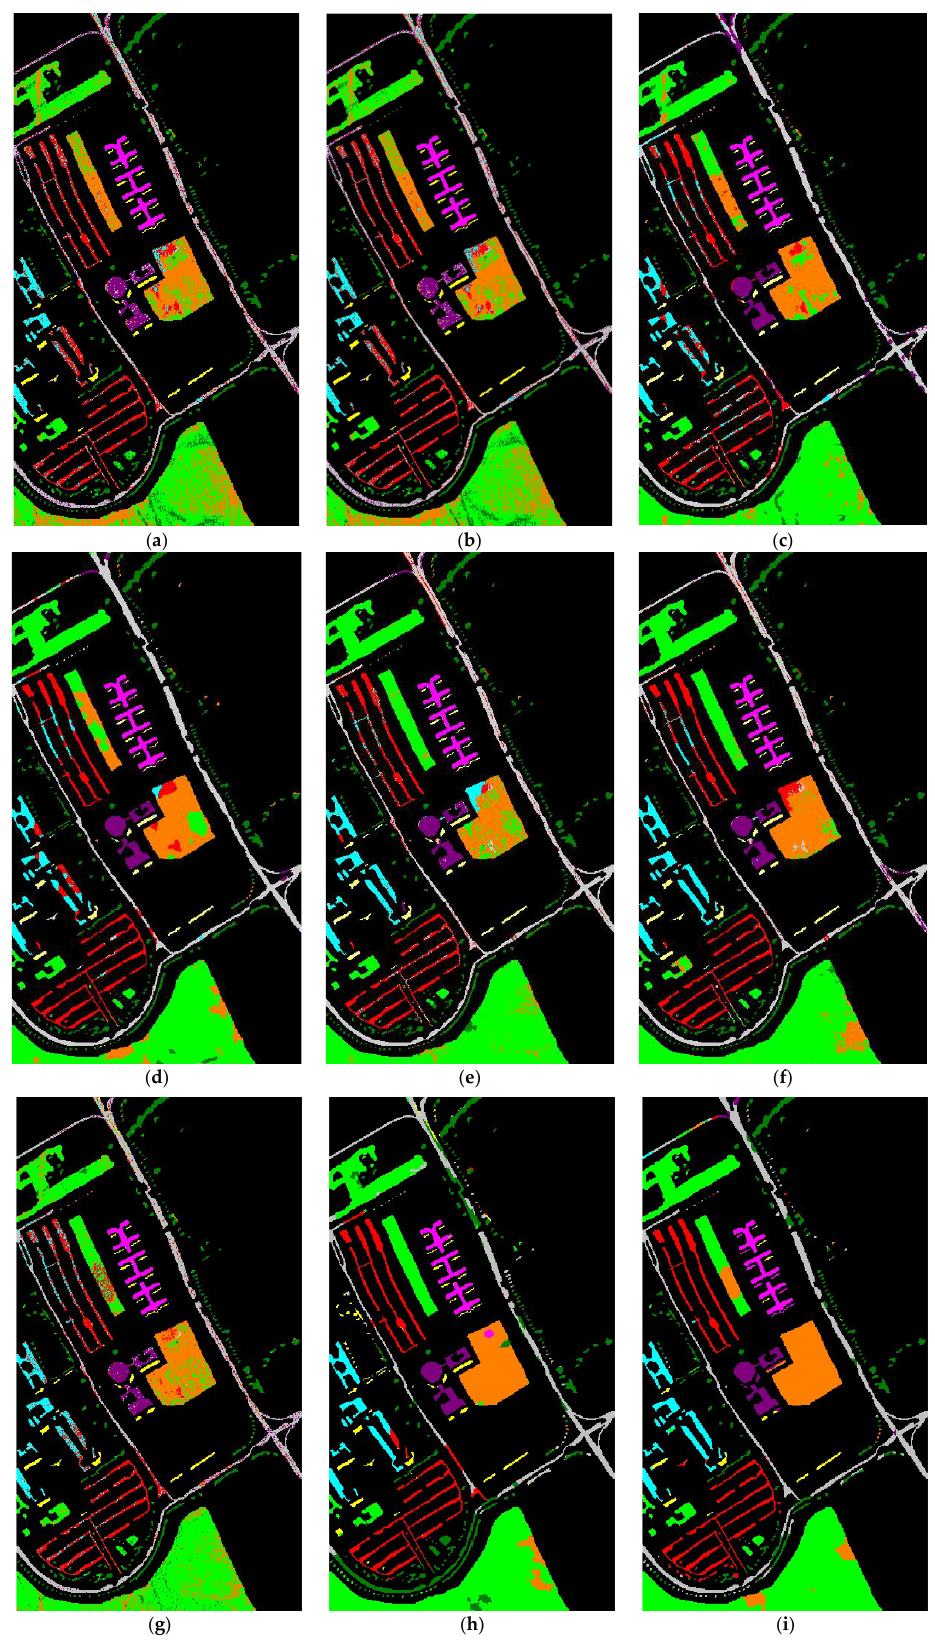
Figure 9. The classification results from the University of Pavia dataset using ( a ) SVM; ( b ) LRR; ( c ) SVMCK; ( d ) SMLR_SpTV; ( e ) SPCK; ( f ) SCMK; ( g ) KLRR; ( h ) Sp_SVM_MKL; and ( i ) Sp_MKL_LRR. Table 2. The classification results on University of Pavia dataset.